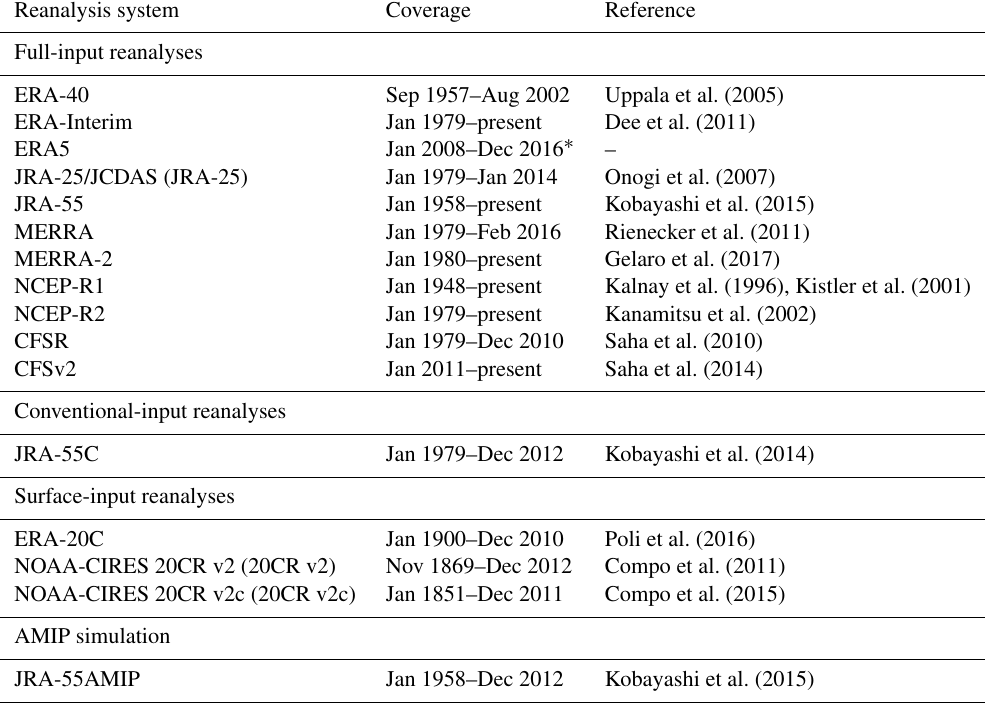
Table 1. The atmospheric reanalyses analyzed in this study. Full-input reanalyses take into account new observations as they become avail- able, while conventional-input reanalyses specifically exclude satellite based observations and surface-input reanalyses ingest only surface measurements. The availability of surface and conventional observations does fluctuate with time, however, such that these reanalyses are not immune to spurious trends associated with changes in the observation network. The JRA-55AMIP provides an free running integration of the JRA-55 atmospheric model forced with observed sea-surface temperatures, as in an Atmospheric Model Intercomparison Project (AMIP)